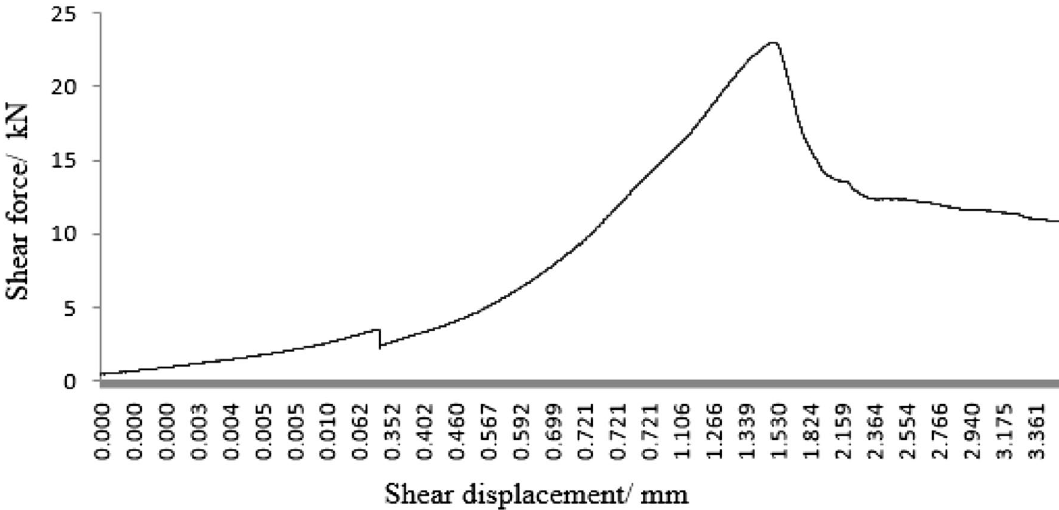
Figure 45. Shear force–shear displacement curve for a specimen containing 1–2.56 mm sand particles (one grain size range).